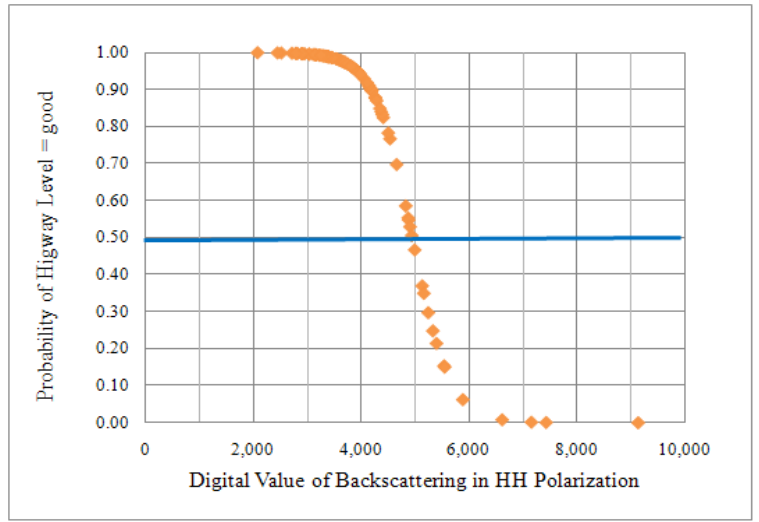
Figure 7. Relationship between backscattering and the probability of selecting highway number 3467 with service level =